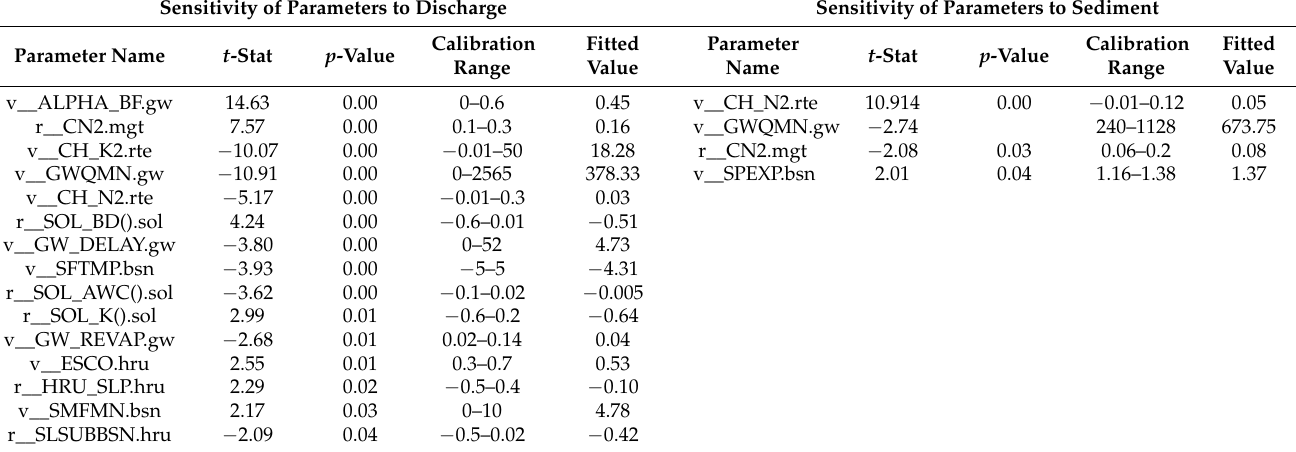
Table 2. List of sensitive parameters ( p < 0.05) (ranked in descending order) to discharge and sediment ( v = replace, r =